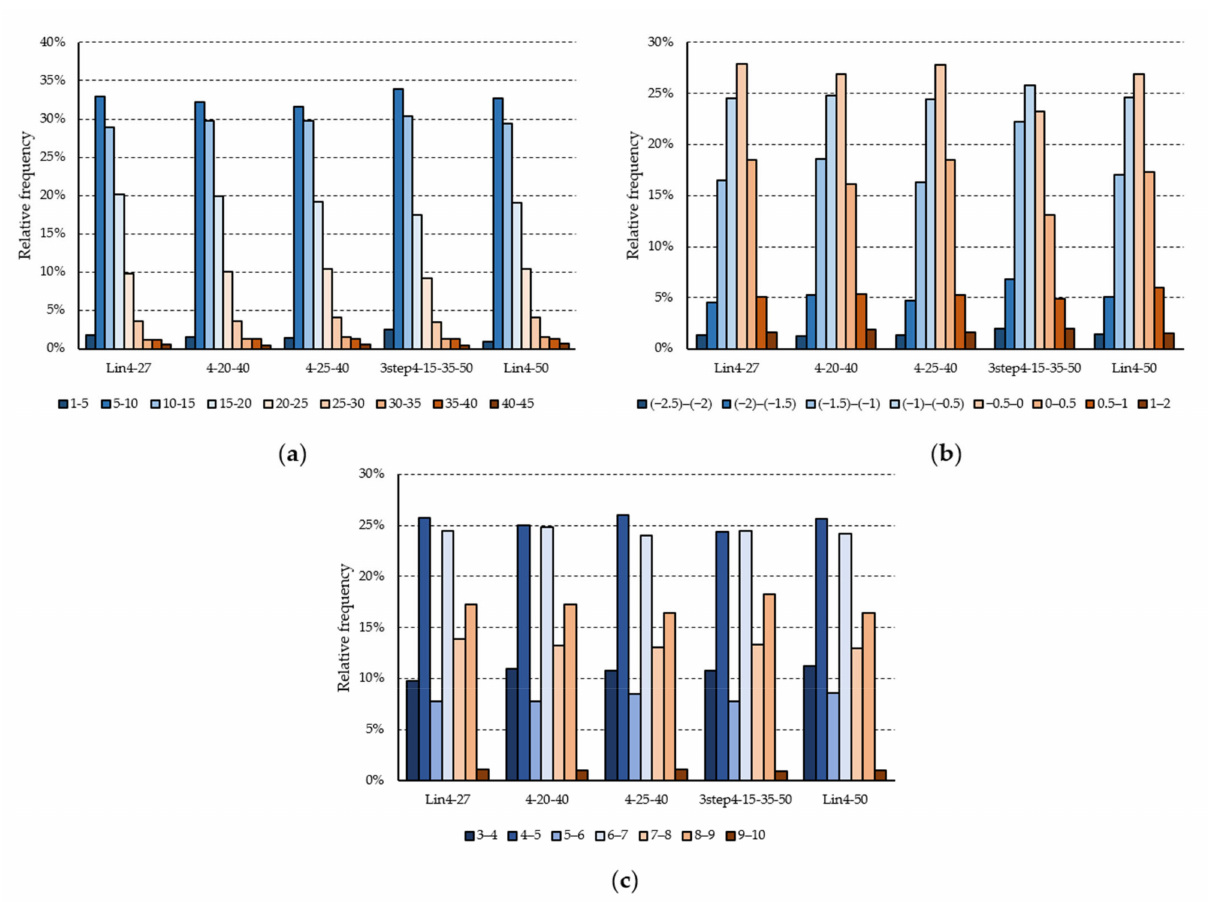
Figure A3. Detection selectivity with the presented gradients. ( a ) Peptide length distribution, ( b ) GRAVY score distribution, and ( c ) Isoelectric point distribution. Note that the last bar in panel ( b ) denotes a different range than all the other